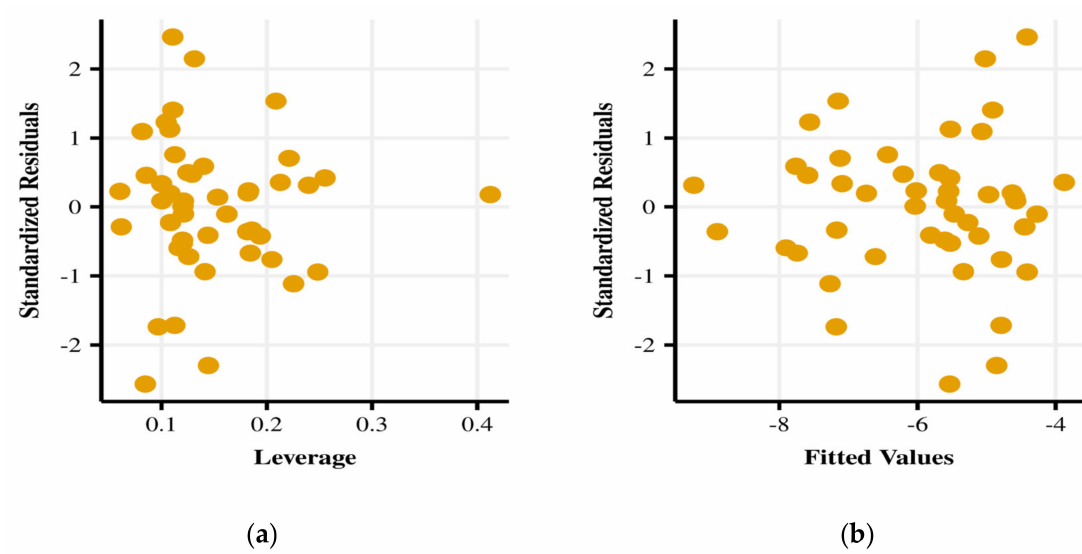
Figure 2. Plots of leverage ( a ) and fitted values ( b ) versus standardized